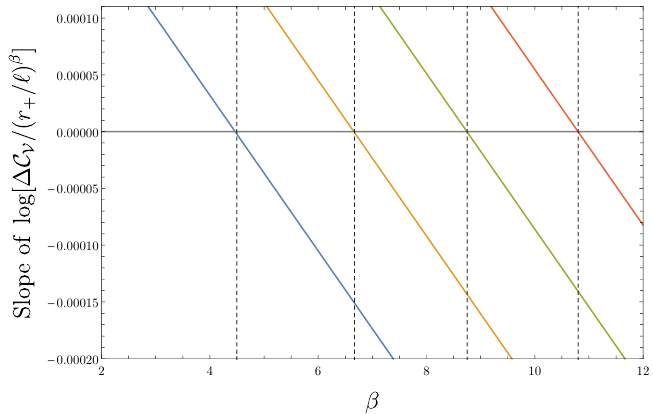
Figure 18. The slope of the logarithm of the ratio R ( β ) for rotating black holes in several dimensions. The curves correspond to 5,7, 9, 11 dimensions from left to right, respectively. For each value of β the integrals have been evaluated for 500 points laying between r + /‘ = 10 , 000 and r + /‘ = 20 , 000 . The slope is extracted by performing a linear fit to this data. In all cases we have set (cid:15) = 10 − 10 to probe close to extremality. Vertical dashed lines have been added to aid in seeing where the slopes cross the horizontal